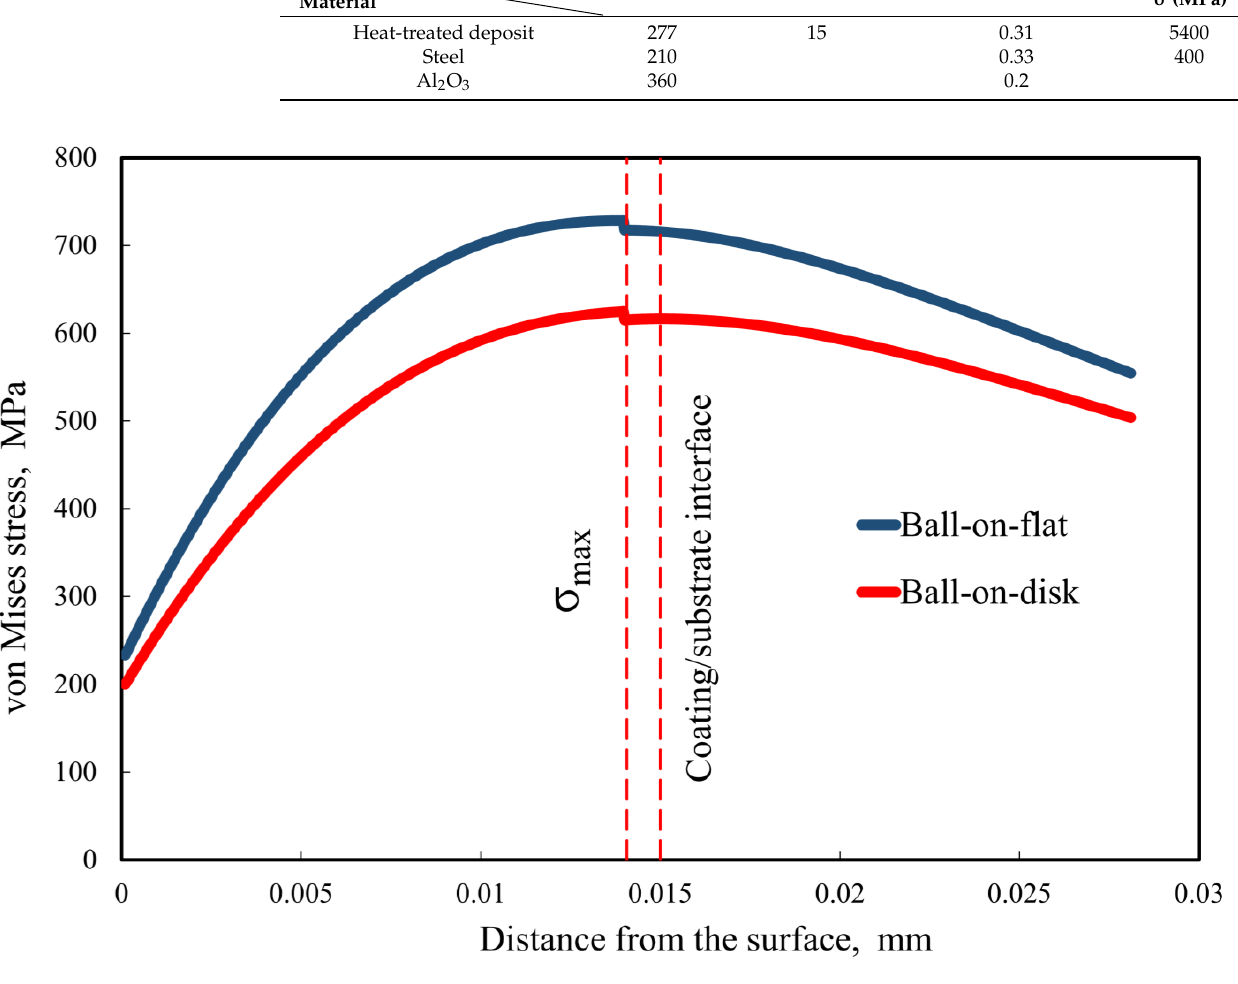
Figure 7. Change in the von Mises Stress for the heat-treated coating during both the ball-on-disk and ball-on-flat sliding tests.